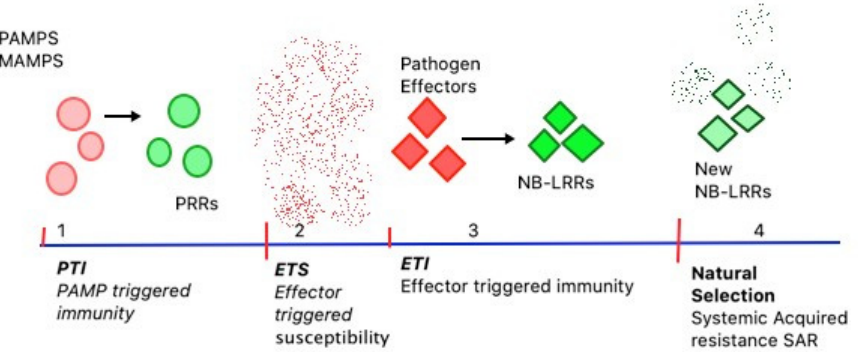
Figure 1. The four phases of plant immunity; (1) PAMPS or Pathogen Associated Molecular Patterns released by the pathogens come in contact with the plant’s PRRs or Pathogen Recognition Receptors used by the plants to recognize pathogens triggering PAMP Triggered Immunity (PTI) or PAMP triggered immunity. (2) Pathogen progresses inside the plant cell taking over PTI and causing ETS or Effector-triggered susceptibility. (3) Plant Nucleotide-Binding and Leucine-Rich Repeat Products (NB-LRRs) interact with pathogen effectors initiating ETI (effector-triggered immunity) responses by the plant. (4) Pathogens produce new effectors proving ETI insufficient. At this stage, natural selection plays its role, plants develop new resistance genes over the course known as Systemic Acquired Resistance or the pathogen invasion is successful [15,19].